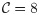
1-factorization.Illustration of the solution of the 1-factorization problem of a graph with C=8 many nodes. Node 8 gets arranged centrally and at each step the pattern is rotated by one.